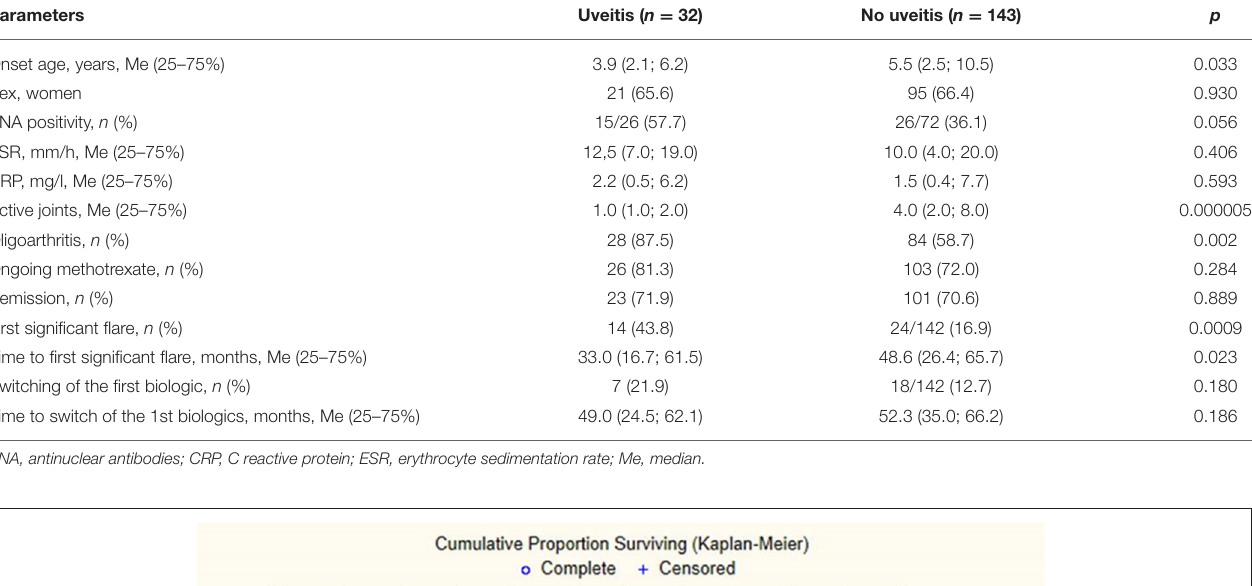
TABLE 1 | The main demographic parameters of the study population. Parameters